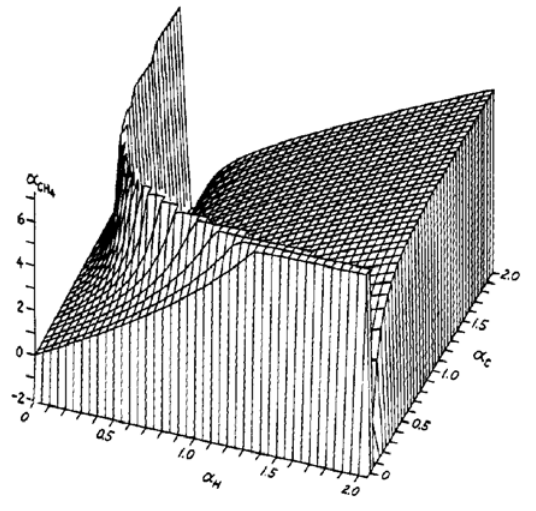
as a function of polarizabilities of H and C [4]. Units are Figure 1. Polarizability of CH 4 Å 3 . Drawn with subroutine THREED (H. Jespersen, Iowa State University Computation Center). The vertical coordinate was truncated at 7 and